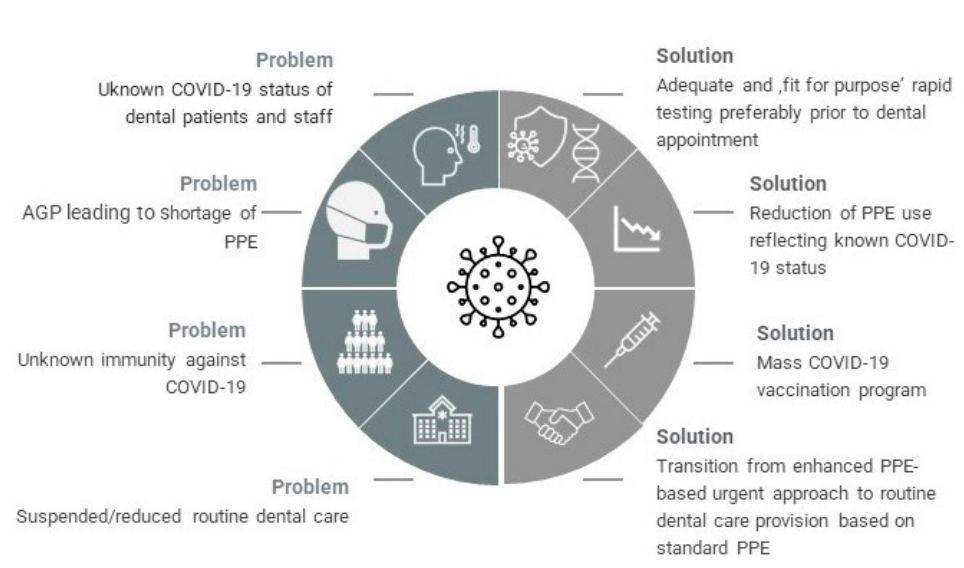
Figure 6. Prioritization of mitigation measures in dental care. The staged reinstallation of dental practice during and after the COVID-19 pandemic.